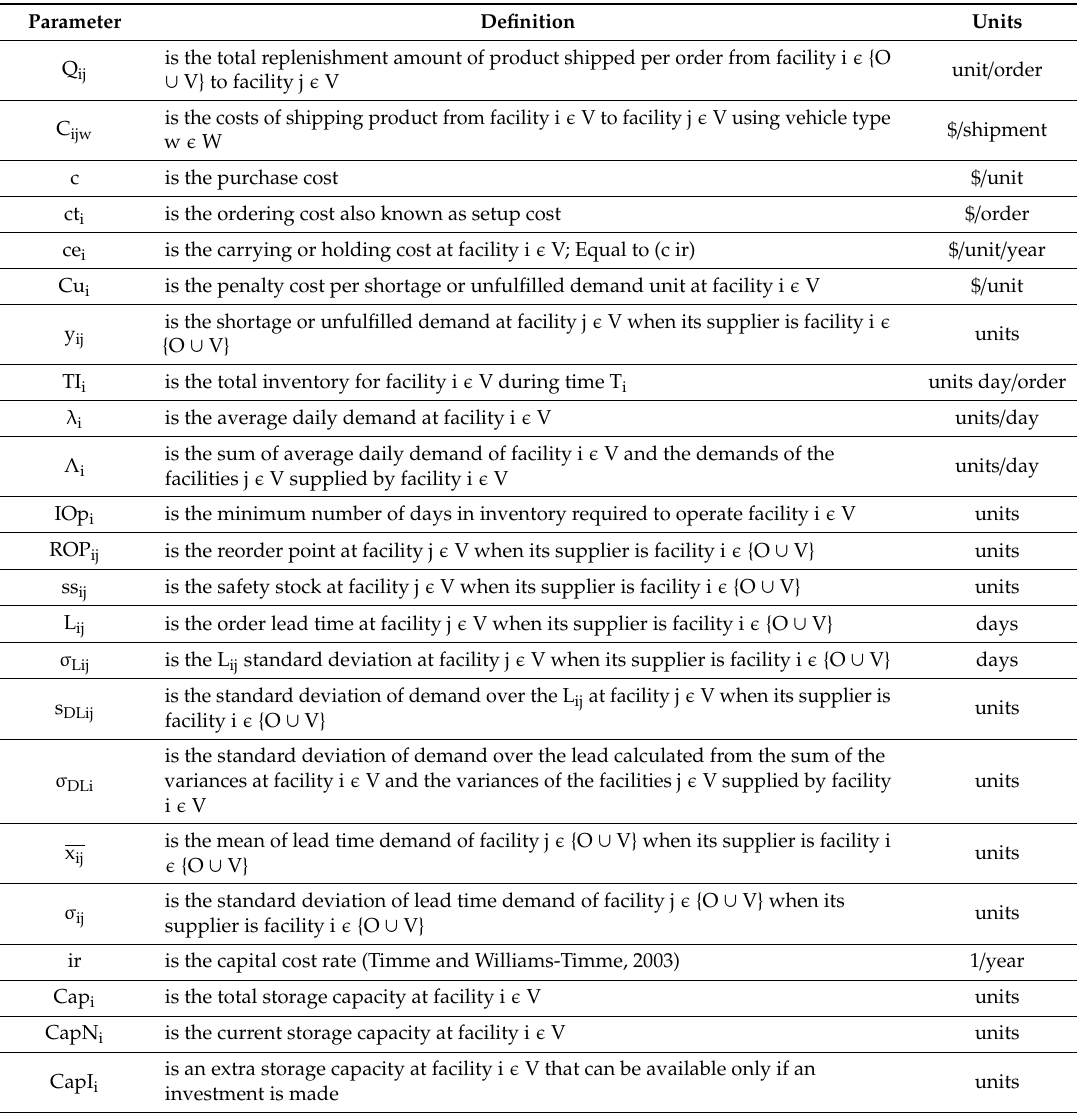
Table 3. CLITraP-HTF parameters [17].